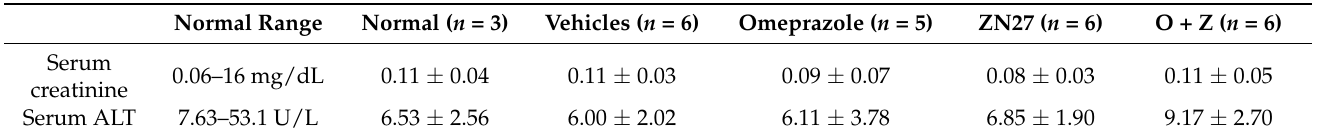
Table 1. ZN27 does not affect creatinine and alanine aminotransferase (ALT) levels in the ongoing aspirin-induced gastric injury